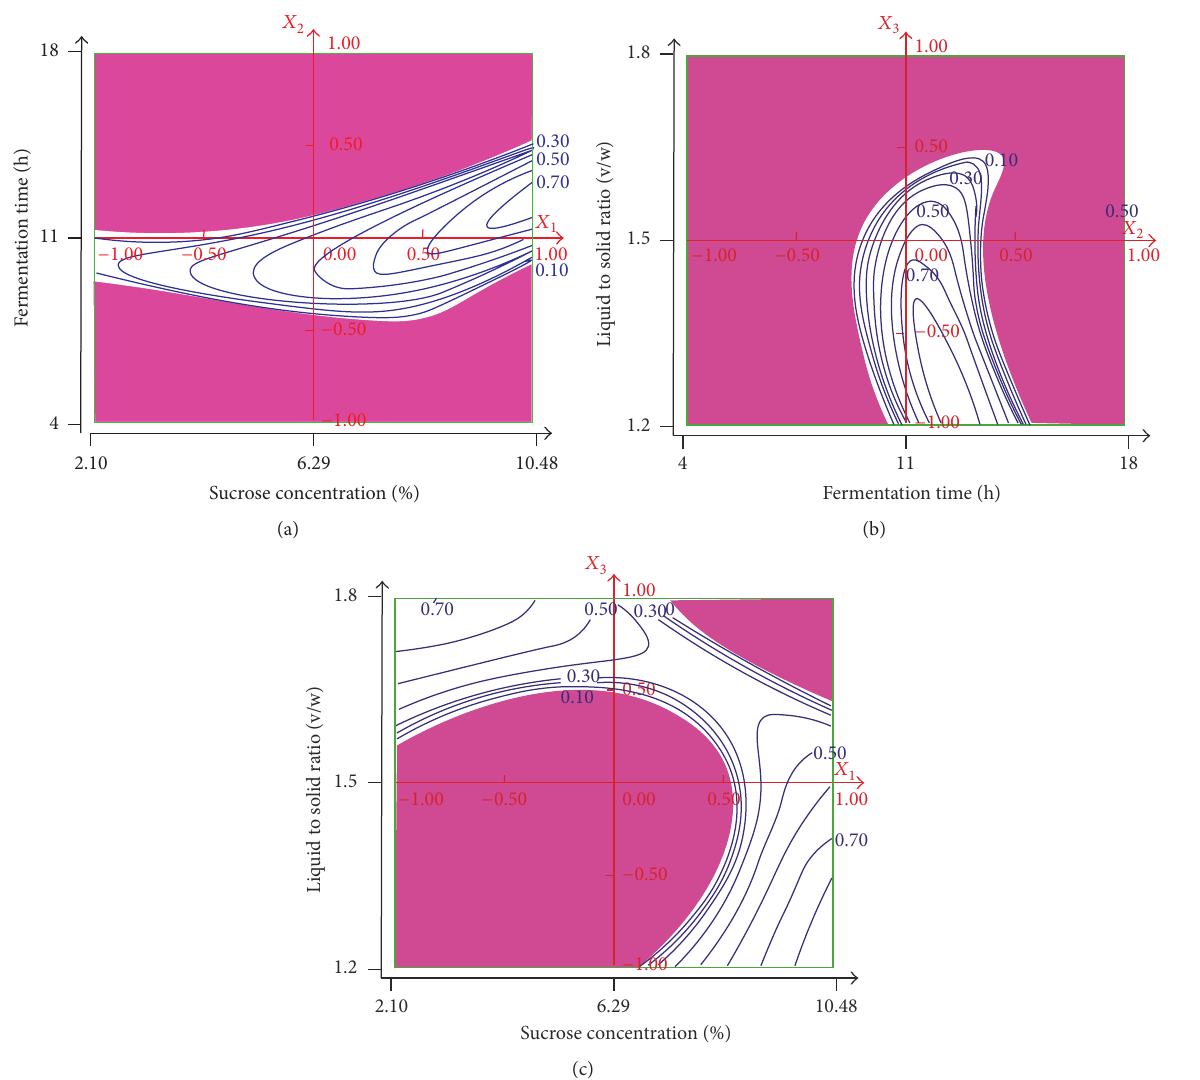
Figure 3: Desirability fitted 2D surface that represent the effect of fermentation time and sucrose concentration (a); liquid to solid ratio and fermentation time (b); liquid to solid ratio and sucrose concentration (c), when 𝑋 1 , 𝑋 2 , and 𝑋 3 are 10.48 g (100 gDM) −1 , 12h, and 1.2(vw −1 ). −1 ; 𝑋 −1 𝑋 𝑋 1 : sucrose concentration g (100g DM) 2 : fermentation time (h); 3 : liquid to solid ratio (vw